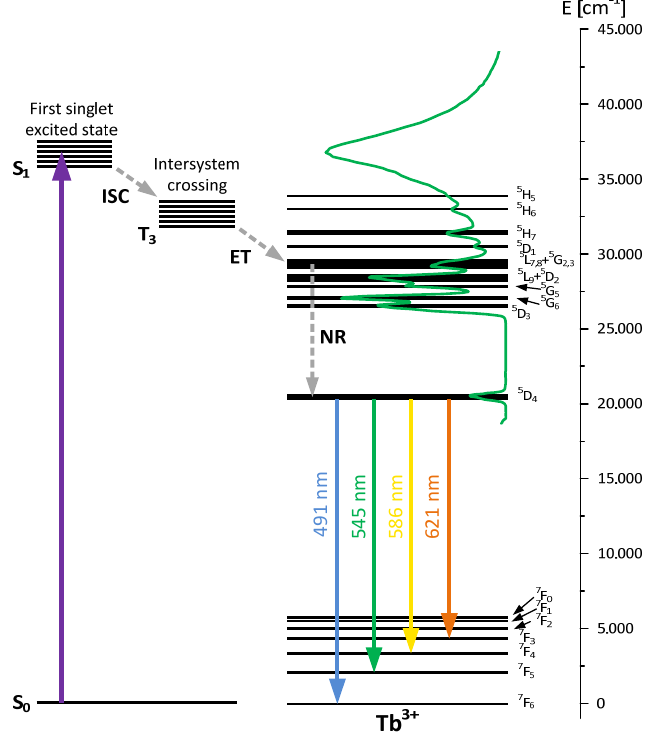
Figure 9. Energy transfer mechanism for Tb(III) sensitized fluorescence as most efficient excitation path together with excitation spectrum and emission transitions from 5 D 4 level (ISC—intersystem crossing, ET—energy transfer, NR—non-radiative transitions).